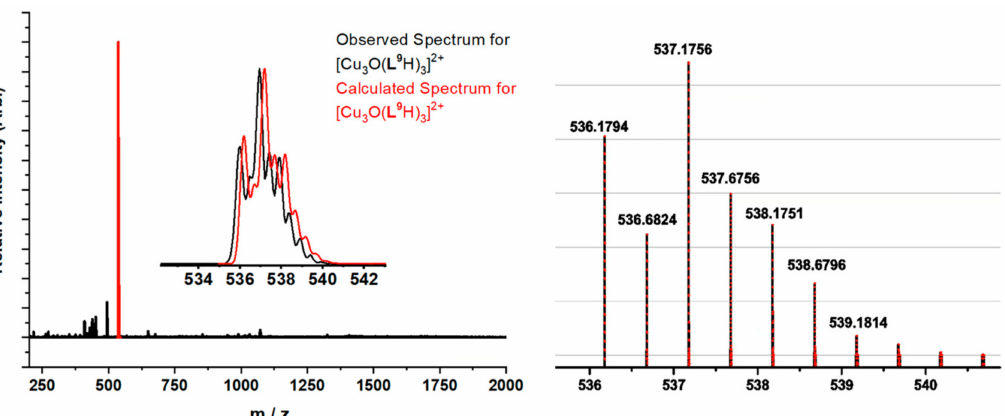
Figure 11. Low and high resolution ( left and right ) plots of the peak assigned to [Cu 3 O(L 9 H) 3 ] 2+ in a mass spectrum obtained from a 50 µ M acetonitrile solution of [Cu 3 OH( L 9 H) 3 (ClO 4 ) 2 ]1.5H 2 O. Optimization of reaction conditions generated a perchlorato complex in 91% yield which was assigned the hexanuclear formulation {[Cu 3 OH( L 9 H) 3 (ClO 4 )](ClO 4 )} 2 1.5H 2